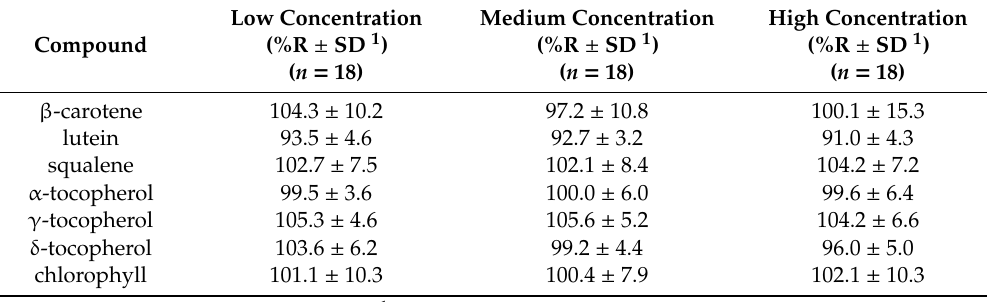
Table 4. %Recoveries (%R) for evaluation of intermediate precision.